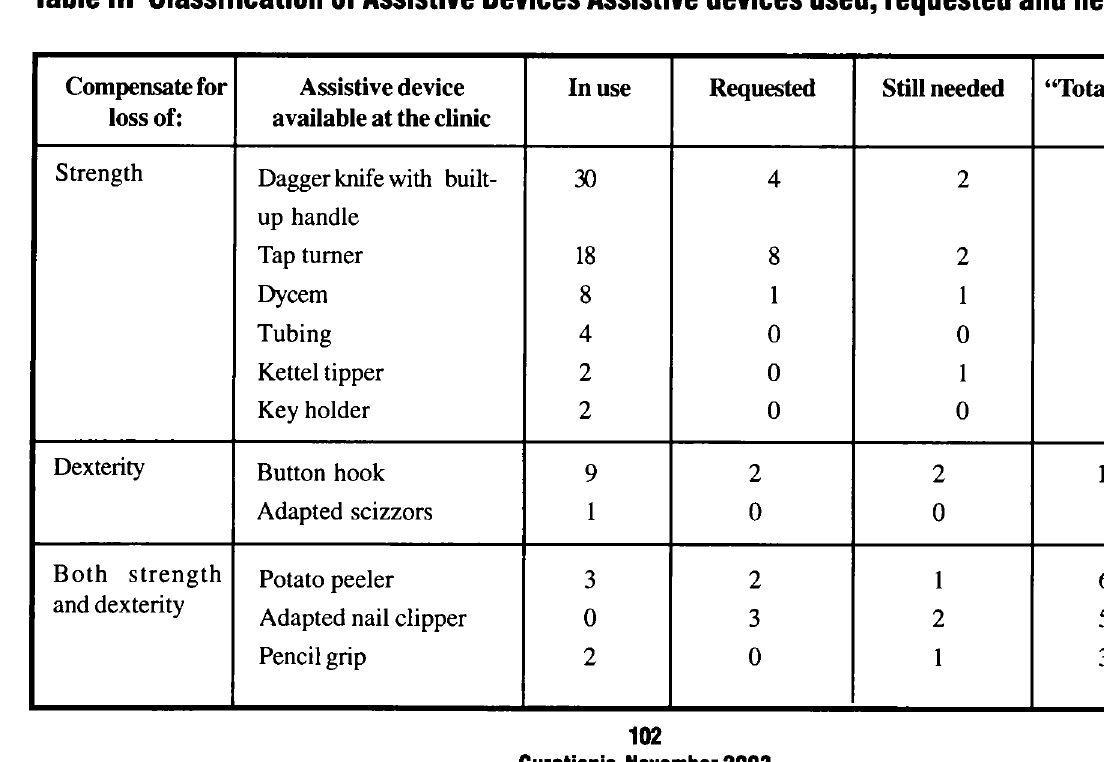
Table III Classification of Assistive Devices Assistive devices used, requested and needed Compensate